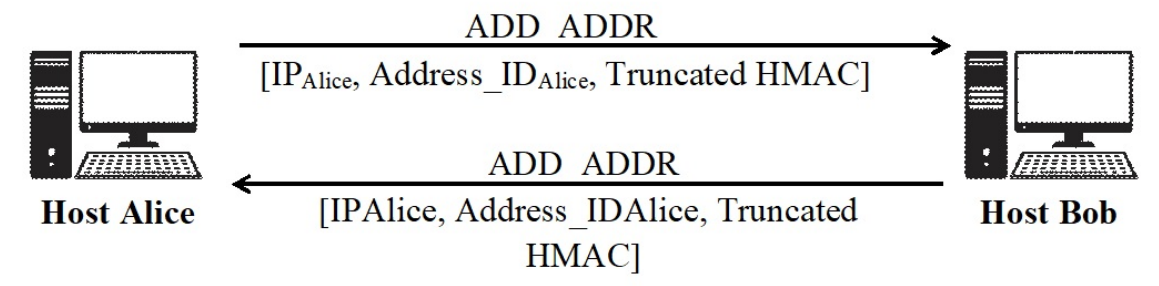
Figure 6. Advertisement of the new IP address with ADD_ADDR in MPTCP Version (v1). These options of MPTCP make it vulnerable to various threats [34] by allowing an attacker to gain access to the MPTCP session. The session can be hijacked either by forging the keys communicated during the three-way handshake or by adding the forged address using ADD_ADDR packets or by using MP_JOIN packets on the communicating host.